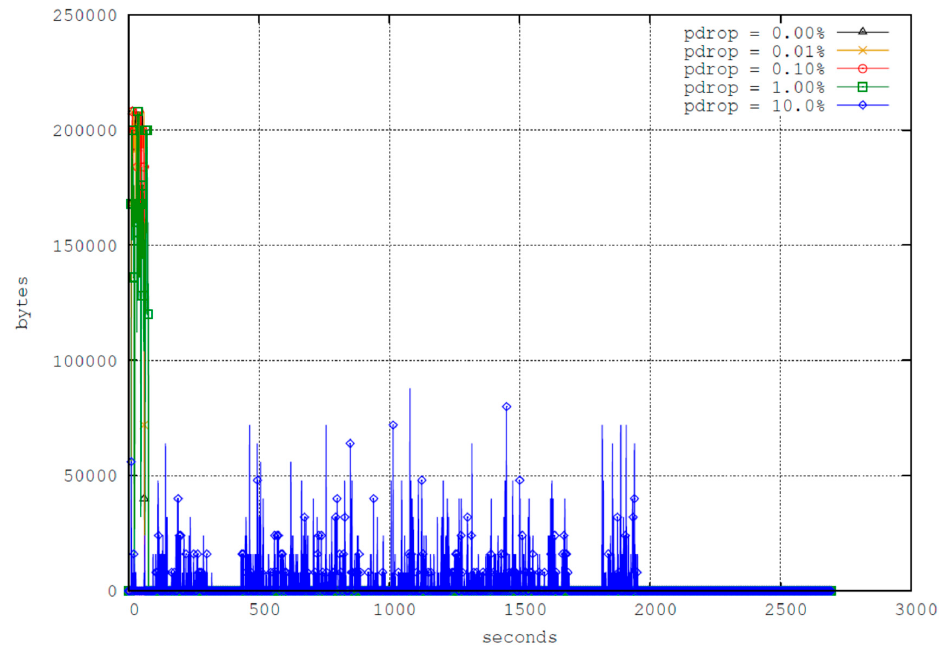
Figure 7. Traffic receiving rate of FTP Clients over 2700 s simulation.